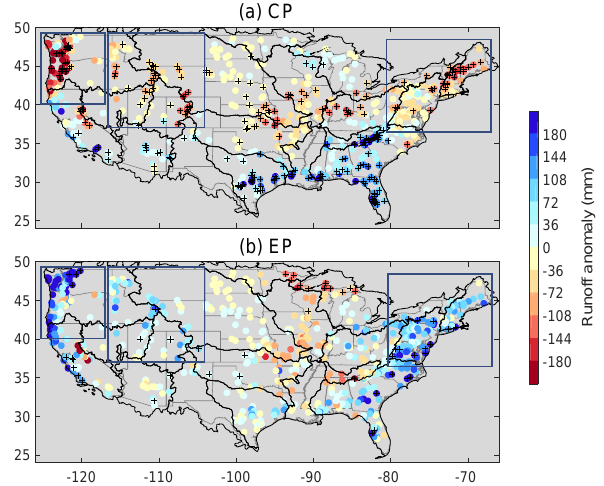
Figure 2. Composite of annual runoff anomaly (unit: mm) for the two types of El Niño during the period of 1990–2009 (a) in CP-El Niño years and (b) in EP-El Niño years. + indicates results at 0.05 significance level based on a Monte Carlo test. Three climate re- gions (NE, PNW, and WNC, based on the climate zones of NOAA; Karl and Koss, 1984) and 18WRRs are plotted using blue rectan- gles and dark black lines,